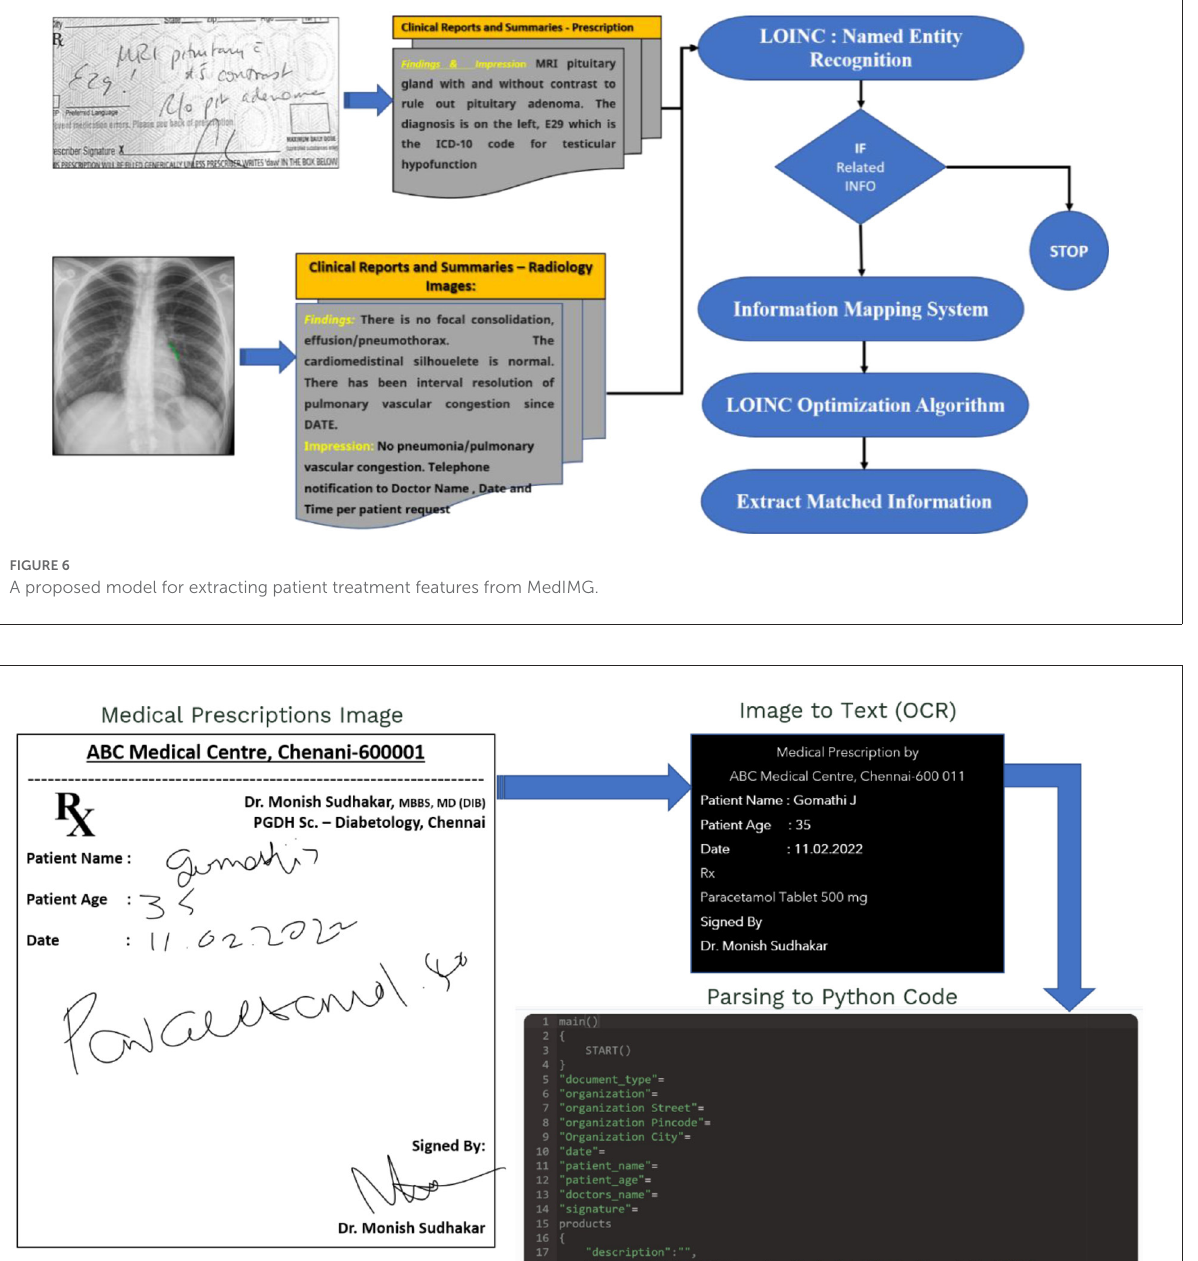
HWNet v2 HWNet v2 is a new version of the HWNet